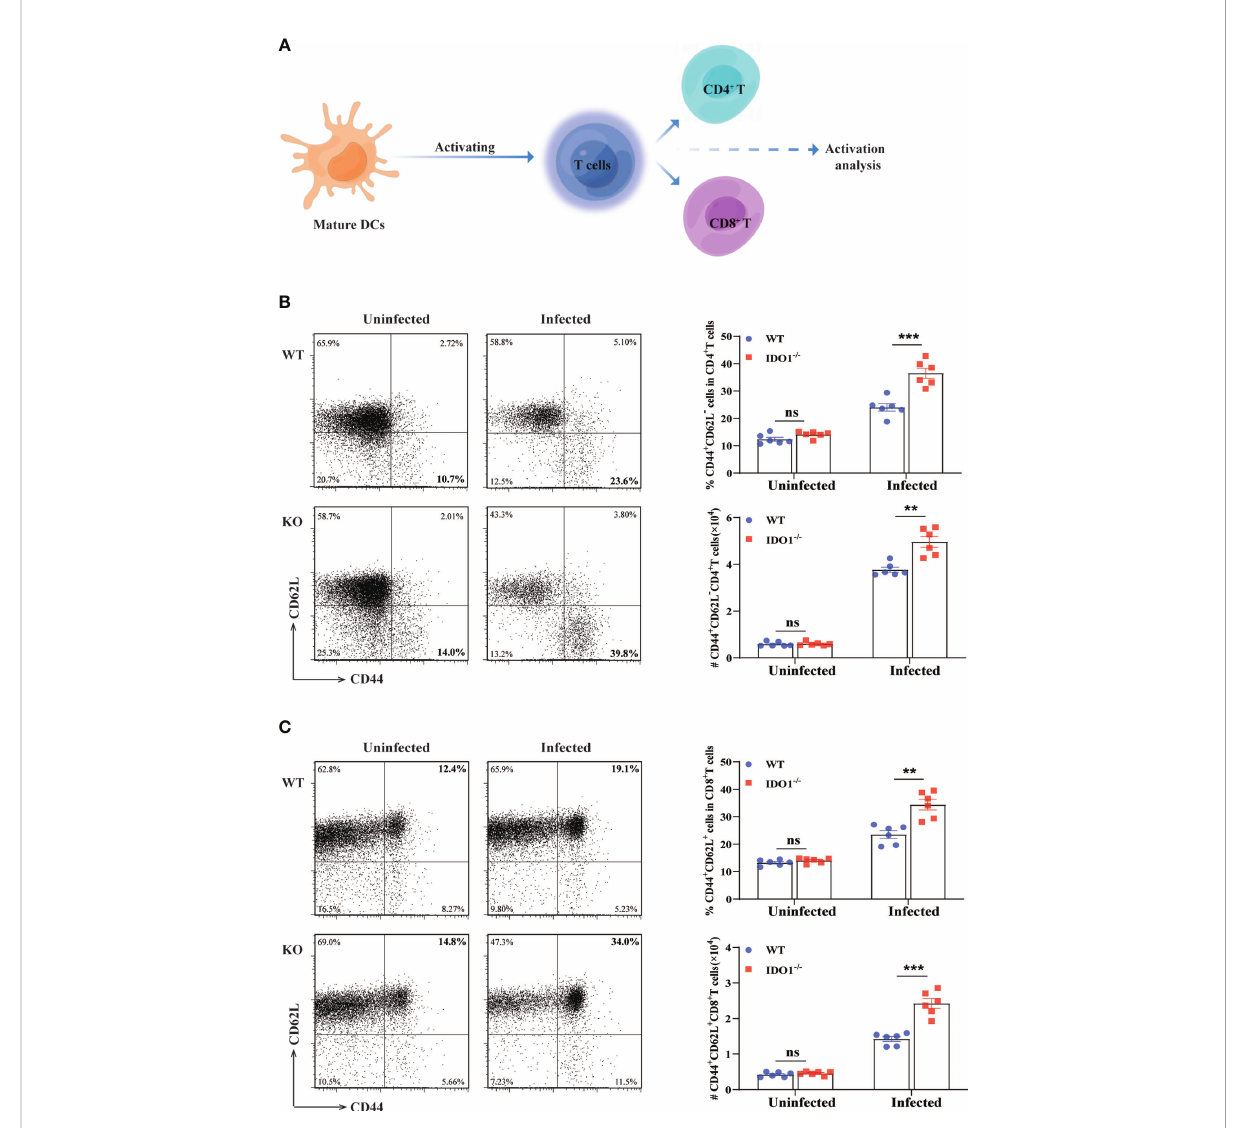
FIGURE 4 Enhanced activation of T cells in IDO1 -/- mice infected with E multilocularis. (A) Conceptual schematic diagram. (B, C) Representative fl ow cytometry plots (left), the frequency (upper right), and the absolute number (lower right) of activated CD4 + T cells (B) , and CD8 + T cells (C) of IDO1 -/- and WT mice at 3 months post-infection with E multilocularis (n = 6/group). CD45 + CD3 + CD4 + and CD45 + CD3 + CD8 + cells were gated respectively for panel (B, C) Data are pooled from 2 independent experiments, and presented as the mean ± SEM. ns, not signi fi cant; **, p < 0.01; ***, p <